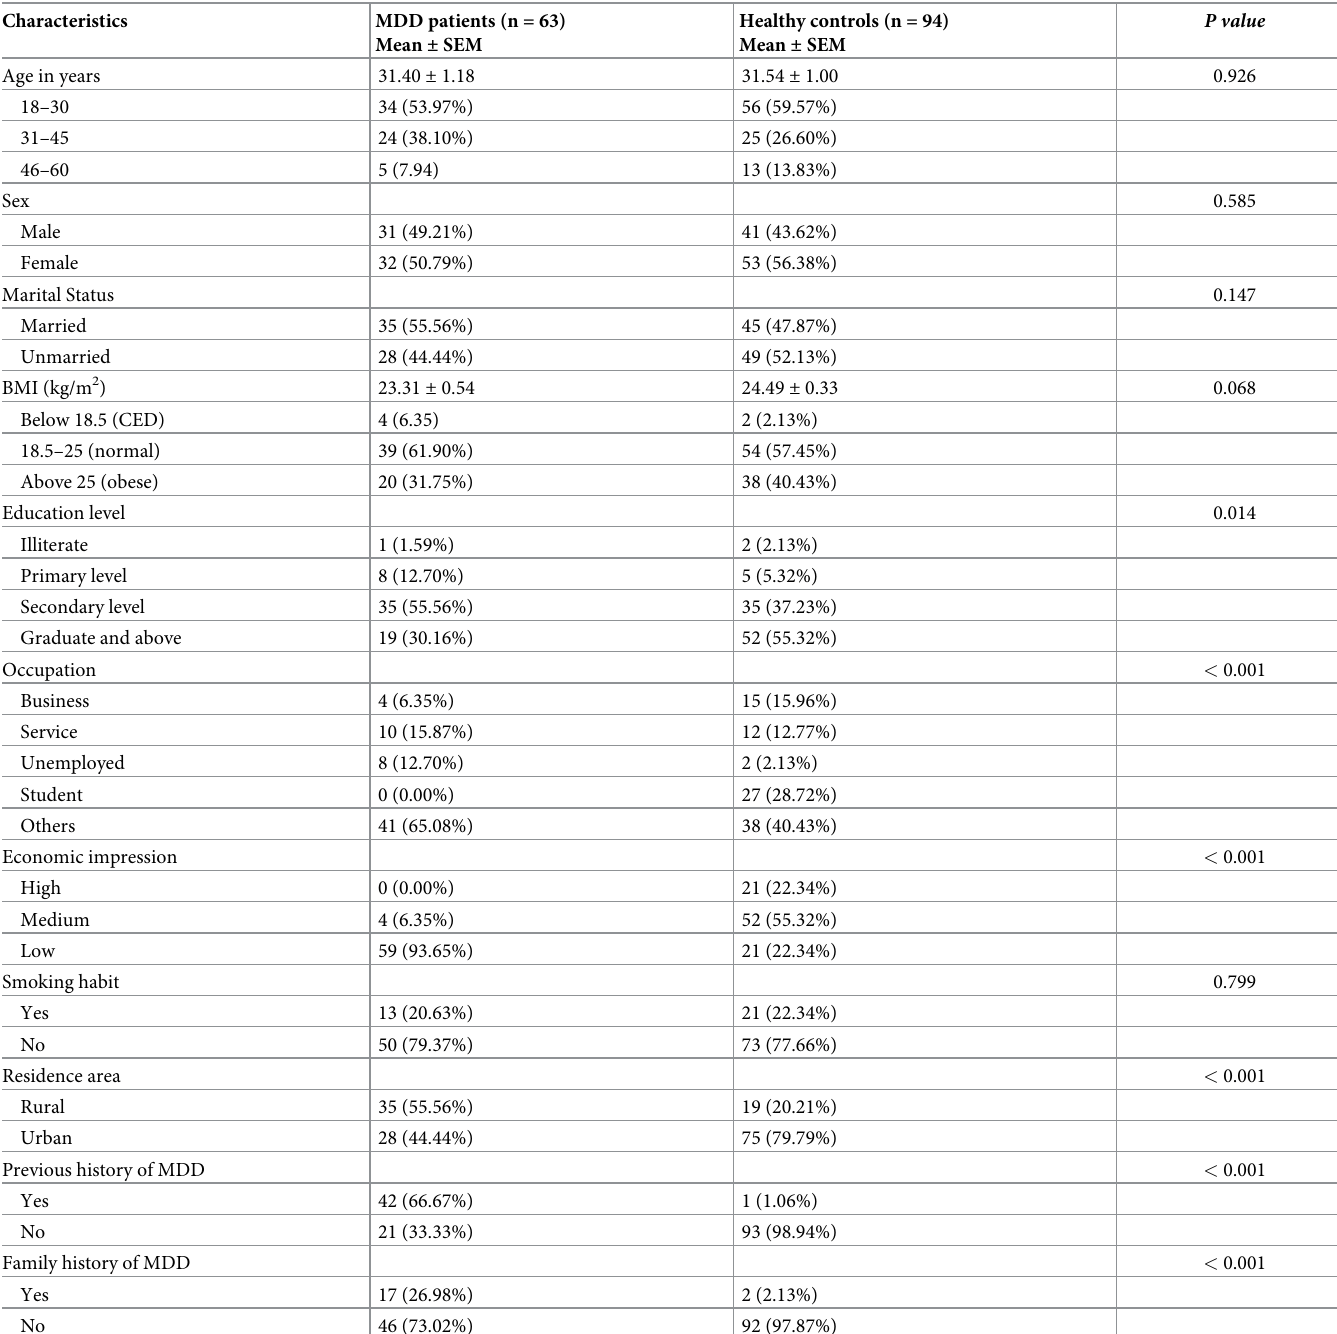
Table 1. Socio-demographic profile of the study